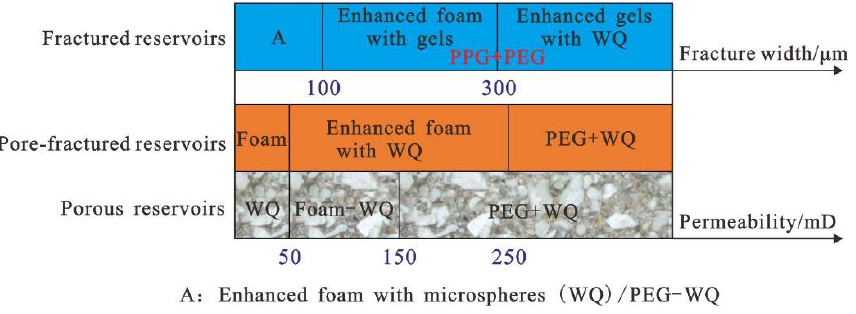
Figure 18. Technique boundary chart of plugging and flooding system in heterogeneous